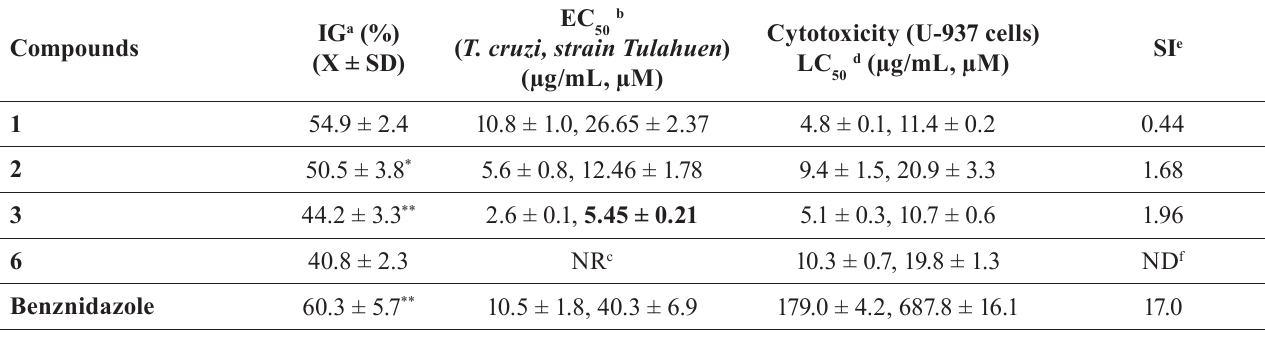
TABLE I - I n vitro Anti-trypanosomal activity and Cytotoxicity of S -allylcysteine ester-caffeic acid amide conjugates